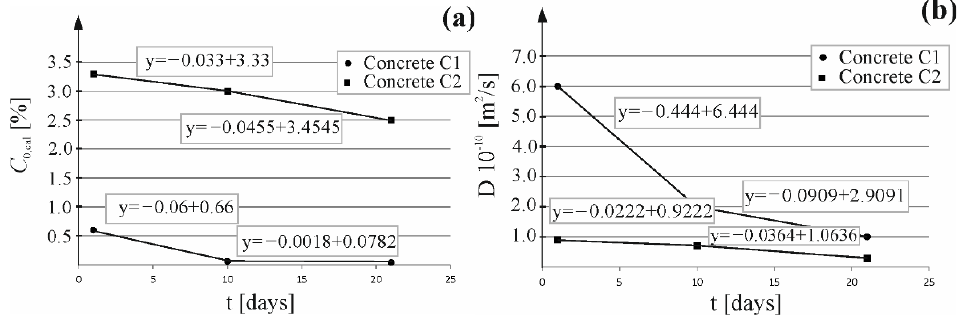
Figure 10. Theoretical linear change: ( a ) of the boundary chloride concentration, ( b ) of the coefficient of chloride extraction during extraction process.